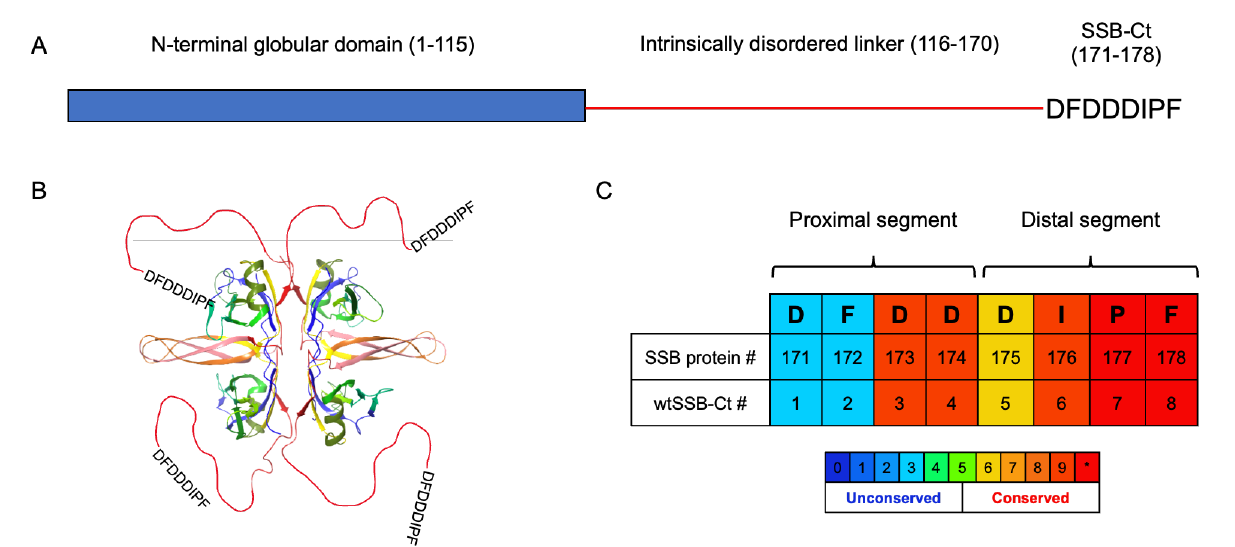
Figure 1. ( A ) Domain structure of E. coli SSB protein. ( B ) Structure of E. coli single-stranded-DNA binding protein as a tetramer (PDB structure 4MZ9). The IDP regions are red lines, and the acidic tips are shown as amino acid sequences. ( C ) SSB-Ct sequence and its numbering as a segment of the whole protein. wtSSB-Ct is an octapeptide with a sequence identical to the SSB-Ct segment. Sequences are colored according to the conservation scores (see lower part of panel ( C ), * denotes the highest score) obtained from PRALINE [31].